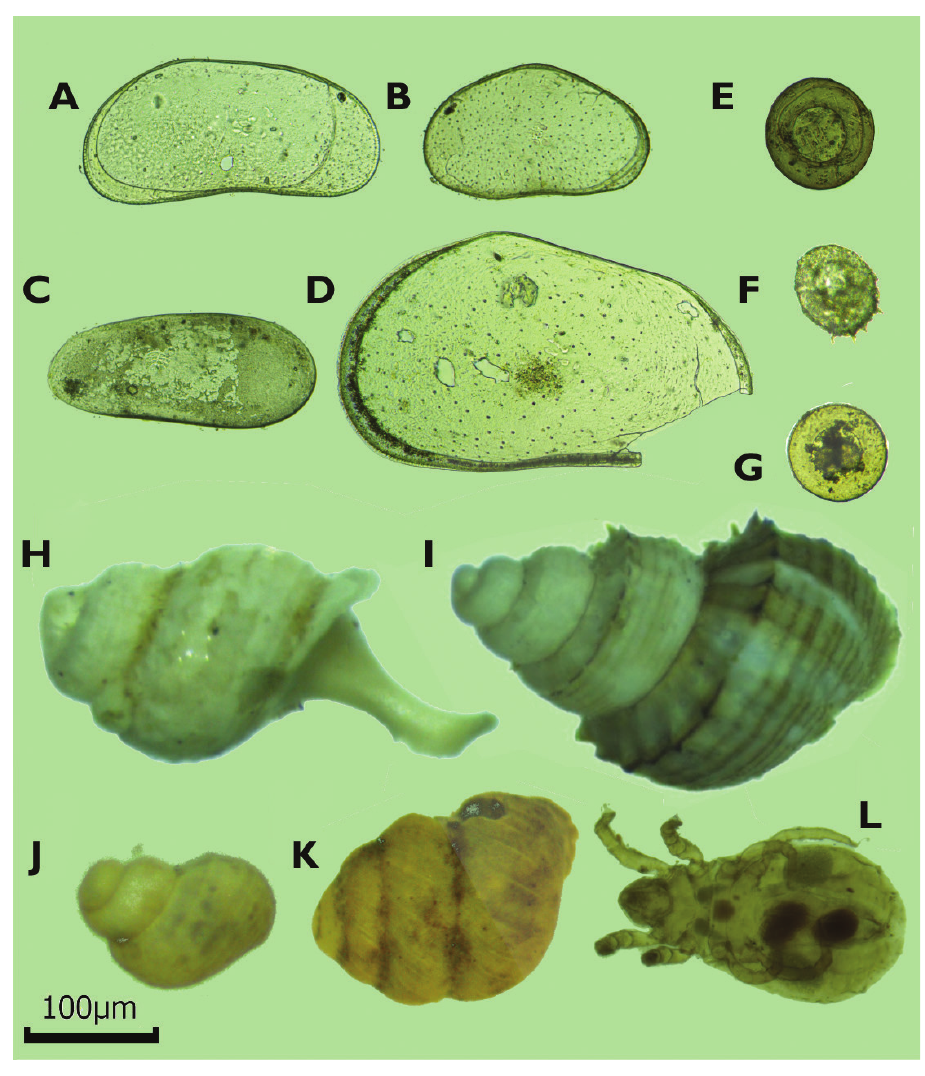
Figure 3. Benthic taxa of sediment samples extracted from Cenote X-Batún A Pseudocandona sp. B Cypridopsis vidua (Müller, 1776) C Darwinula stevensoni (Brady & Robertson, 1870) D Cyprididae sp. E, G Arcella megastoma (Penard, 1902) F Centropyxis discoides (Penard, 1890) H–J Pyrgophorus coronatus (L. Pfeiffer, 1840 K Bothriopupa sp. L Tyrphonothrus